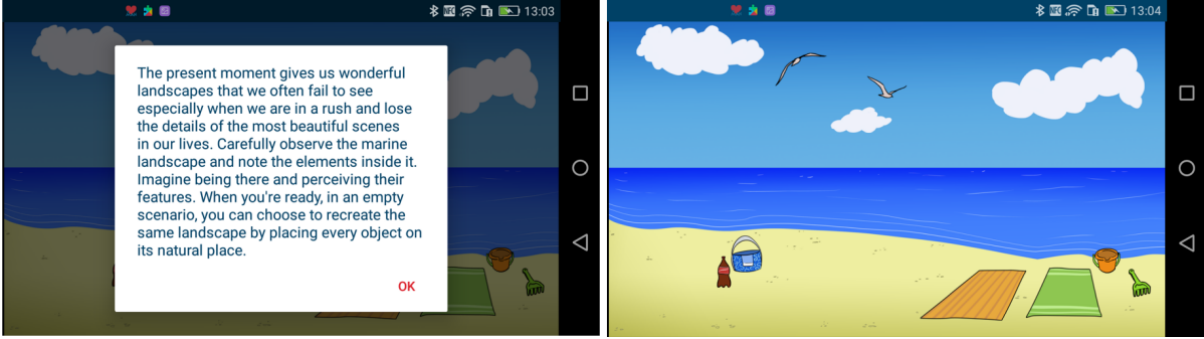
Figure 3. Mindful game "World